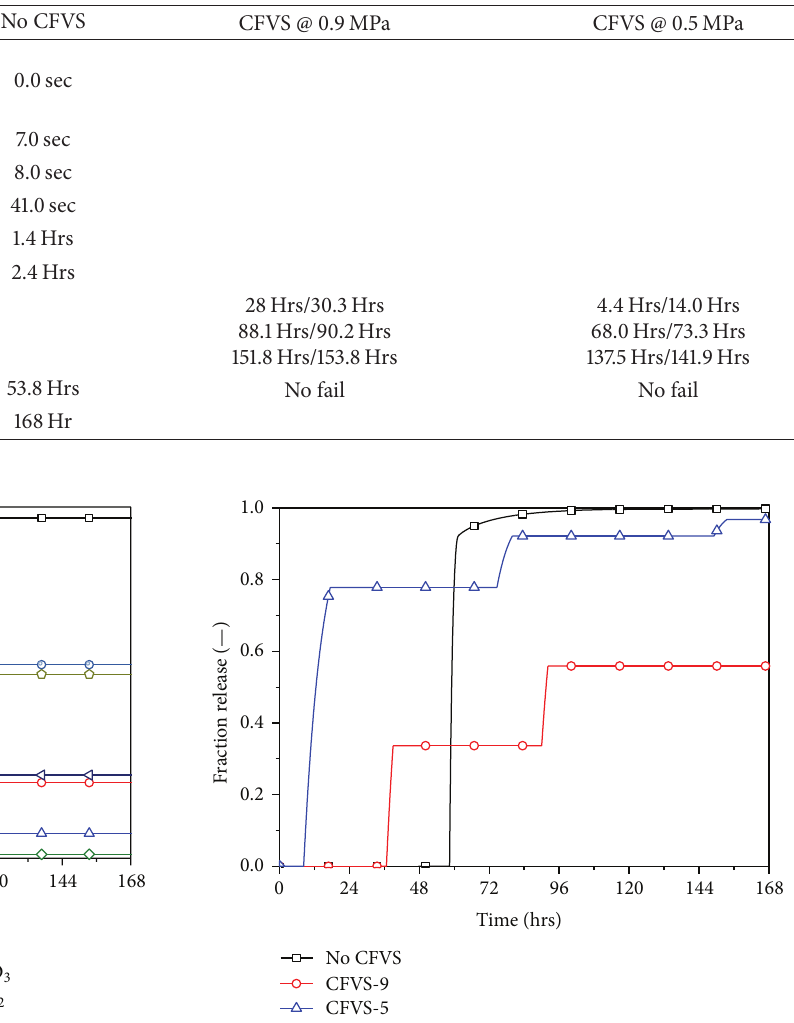
Figure 6: Comparison of fractional release of noble gas in extended